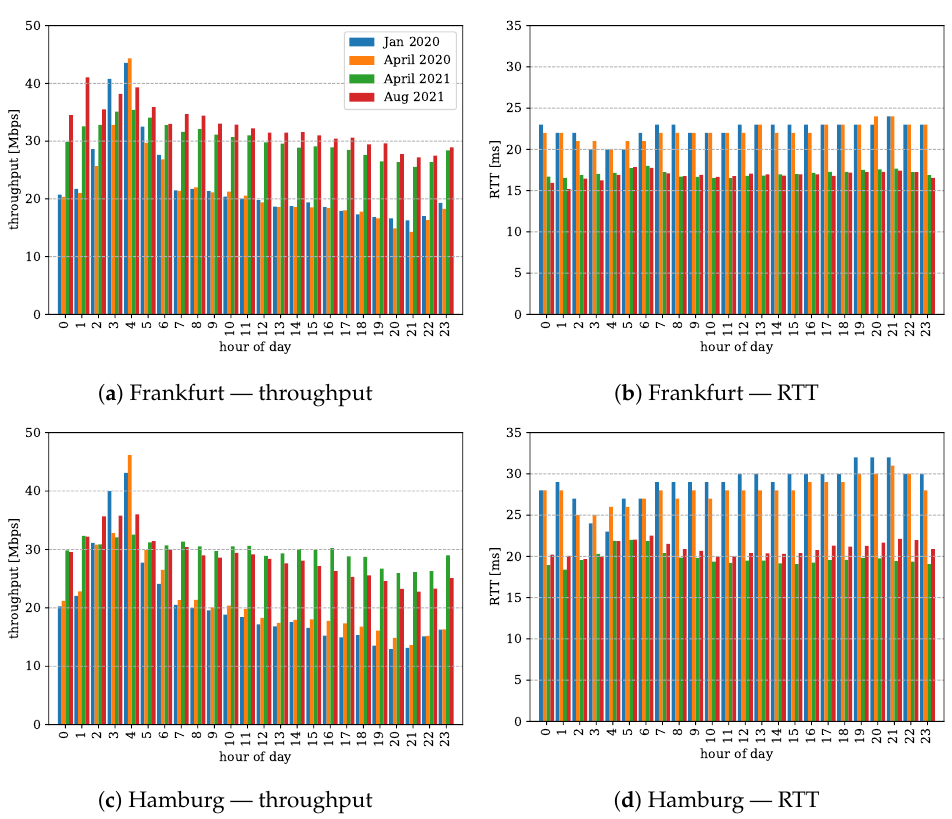
Figure 4. Throughput and RTT per hour of day in January 2020, April 2020, April 2021, and August 2021: During the evening hours, the measured throughput decreases and the RTT increases, where after midnight the throughput increases and the RTT decreases slightly.